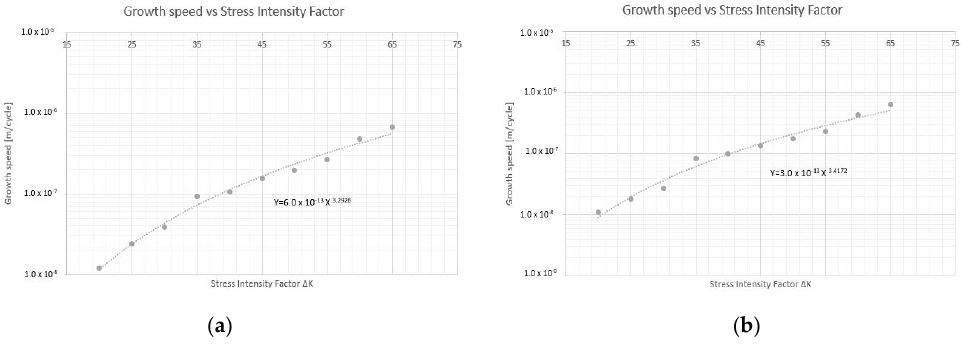
Figure 12. Growth speed vs. intensity factor. ( a ) Bembézar Stringers, m = 3.29; C = 6 × 10 − 13 . ( b ) Bembézar Main Chords, m = 3.41; C = 3 × 10 13 .